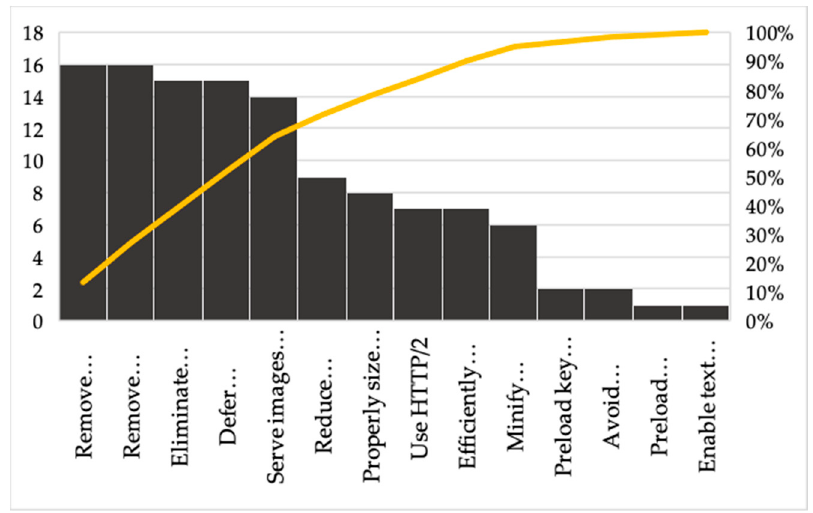
Figure 7. Pareto diagram for the identified opportunities.